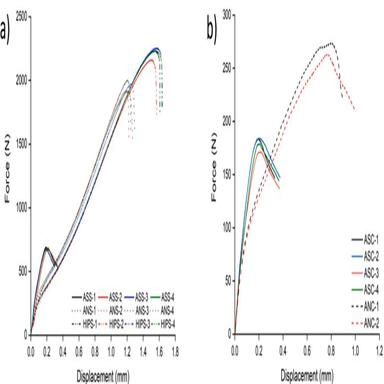
Force-displacement plots of a) 316L Steel and b) copper specimens.